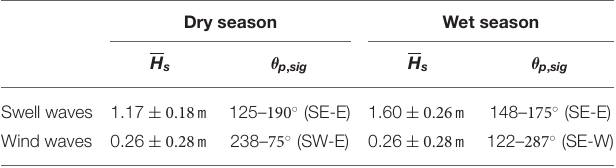
TABLE 1 | Wave parameters for the time series at the ERA5 data node ( Figure 1